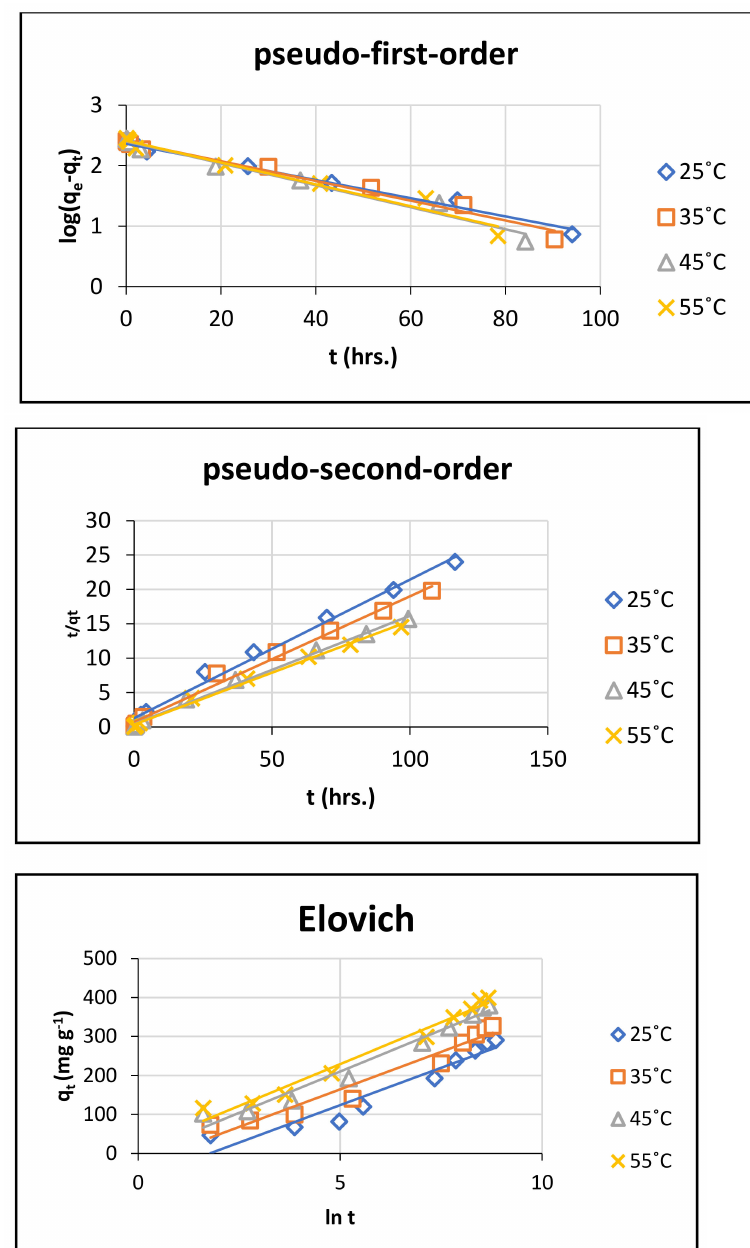
Figure 9. Linear regressions of kinetic plots at different temperatures for the adsorption of CR dye onto UCs (Experimental conditions: 50 mg of adsorbent, 50 mL of dye solution (600 mg L − 1 ) and pH